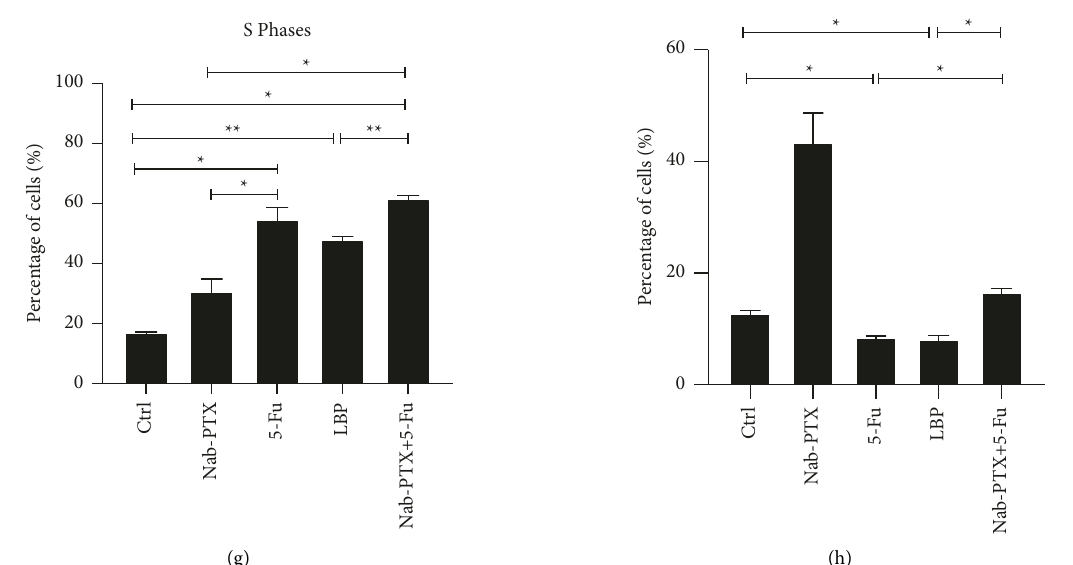
Figure 3: Cycle arrest in each group of AGS cells. (a) The 24h cycle diagram of the control group; (b) the 24h cycle diagram of Nab-PTX (0.2 μ mol/l); (c) the 24h cycle diagram of 5-Fu (2 μ mol/l); (d) the 24h cycle diagram of LBP (10 μ mol/l); (e) the 24h cycle diagram of Nab- T+5-Fu (0.2 μ mol/l +2 μ mol/l); (f) Percentage of cells(%) in G0/G1 phases; (g) Percentage of cells(%) in S phases; (h) Percentage of cells(%) in G2/M phases, and the cell cycle was detected by flow cytometry. All the above experiments were repeated at least three times inde- pendently. ∗ P < 0 . 05, ∗∗ P < 0 .